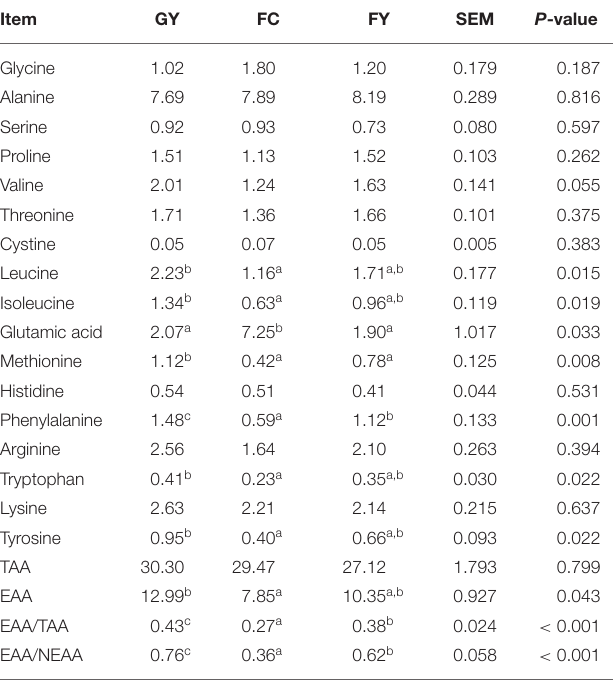
TABLE 7 | Amino acid composition (% DM) of Longissimus thoracis from GYs, FC, and